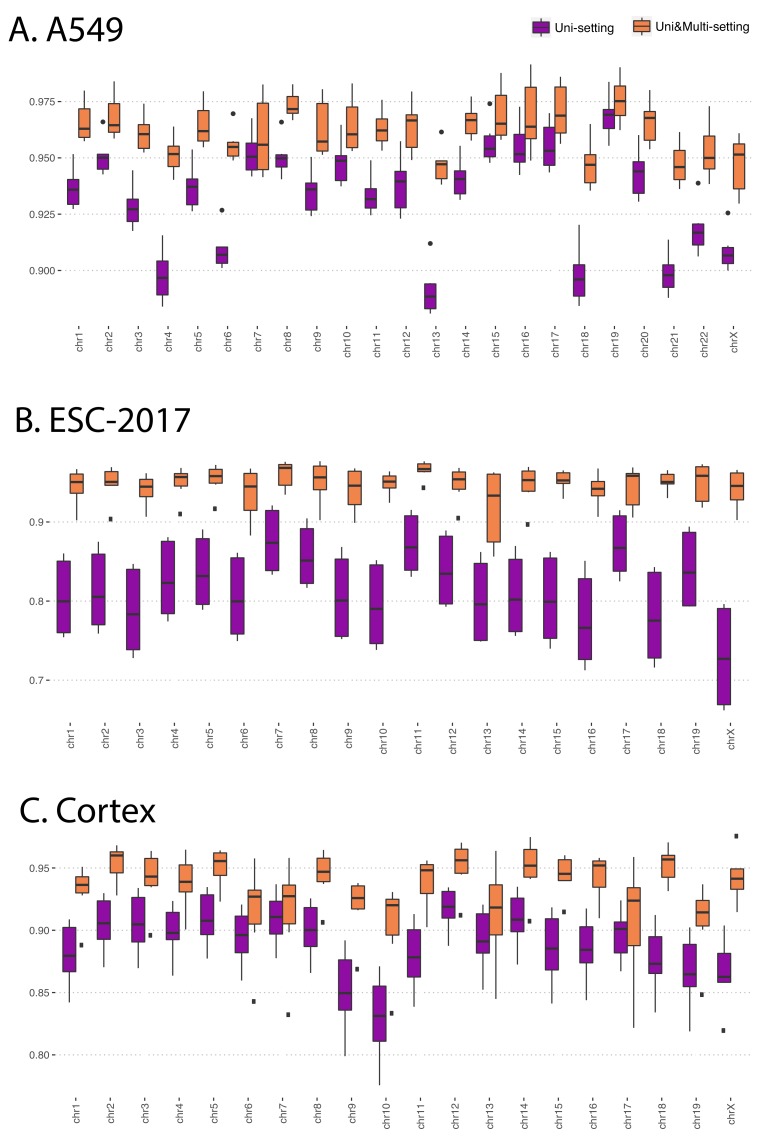
Reproducibility at the contact matrix level under the Uni- and Uni&Multi-settings in A549, ESC-2017 and Cortex cell lines.Note that the box plots for the ESC-2012 cell line which only has two replicates are not displayed.